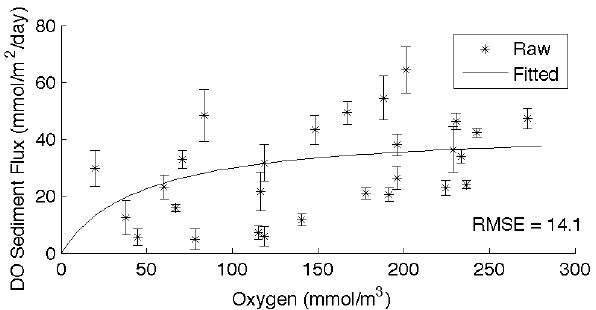
Fig. 5. Comparison of parameterization of the sediment oxygen de- mand (solid; Table 1, Eq. 4) against temperature corrected sediment core incubation experimental data